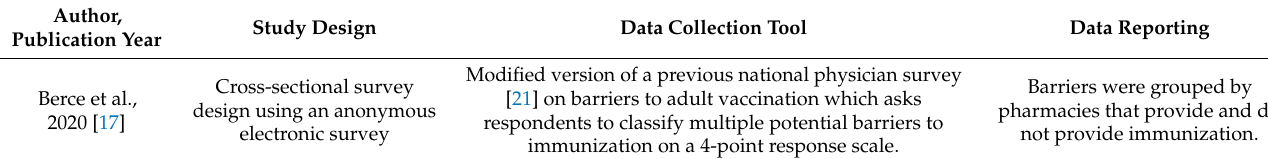
Table 2. Overview of included study methodologies and data